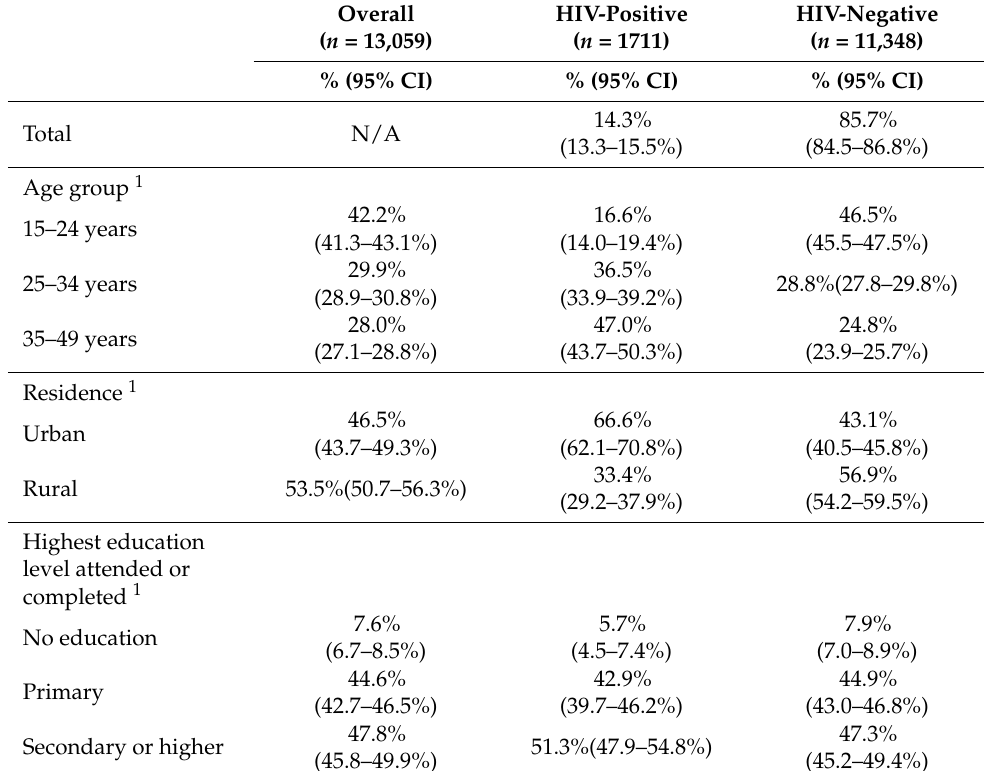
Table 1. Distribution of selected sociodemographic and other characteristics, and tobacco use,